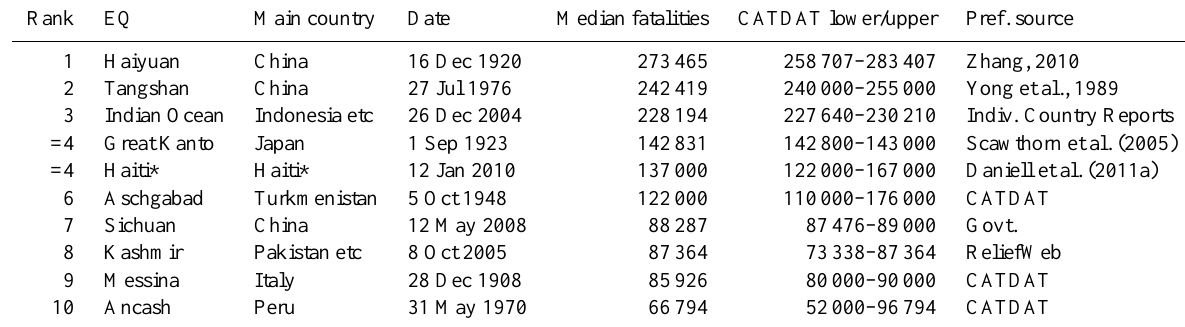
Fig. 5. A comparison of the relative number of damaging earthquakes in the database per country (the darker the area, the greater the number of damaging earthquakes), (CATDAT Damaging EQ Database v4.12, Daniell, 2010a). Table 2. The top 10 death tolls since 1900 in the CATDAT Damaging Earthquakes Database.